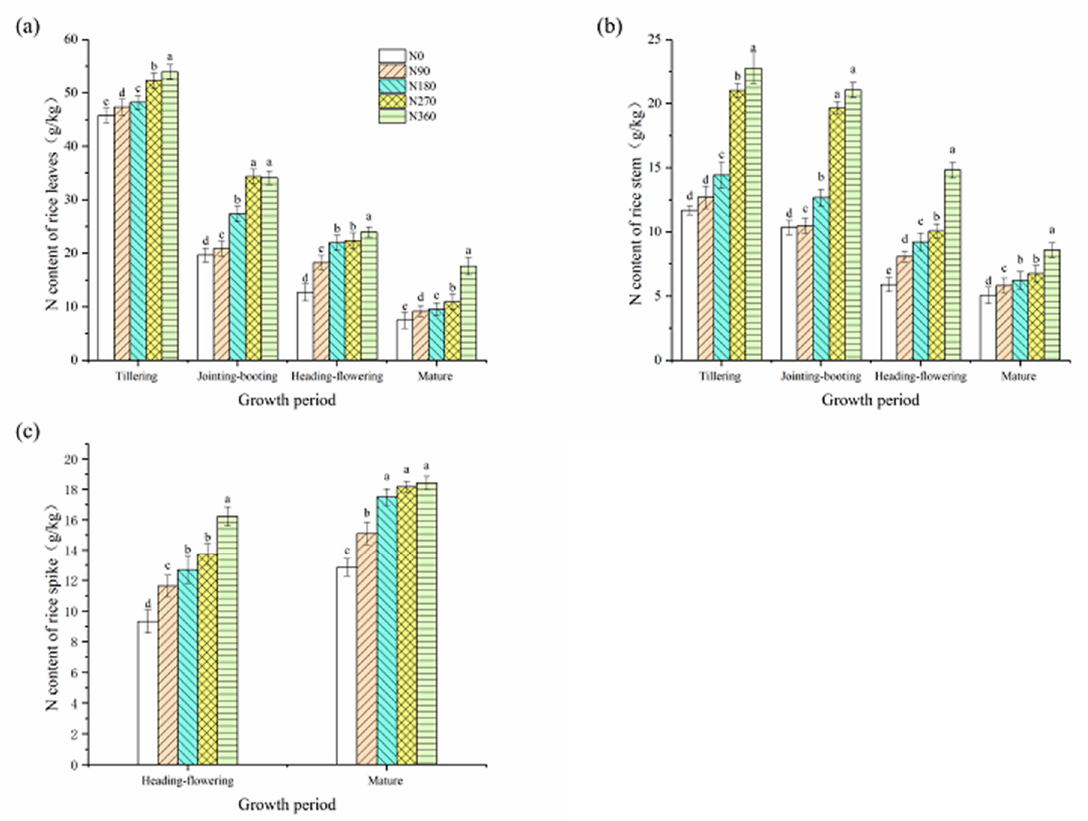
Figure 4. Effects of N application rates on N contents of rice plants. ( a ) N content of rice leaves; ( b ) N content of rice stem; ( c ) N content of rice spikes; vertical bars indicated the standard error. Different letters with the same growth period indicated significant differences at p < 0.05 according to the Duncan’s test. Tillering means tillering stage; jointing–booting means jointing–booting stage; heading–flowering means heading–flowering stage; mature means mature stage. Table 3. Effect of N application rates on rice NUE and yield of double-cropping rice.